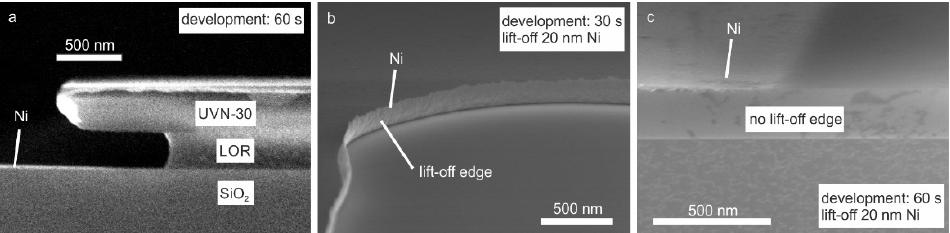
Figure 2. ( a ) Cross section SEM image of a sample after lithography and metal deposition before lift- off. ( b ) Example of a lift-off edge due to an insufficiently large undercut. ( c ) Example of a grid line without a lift-off edge.